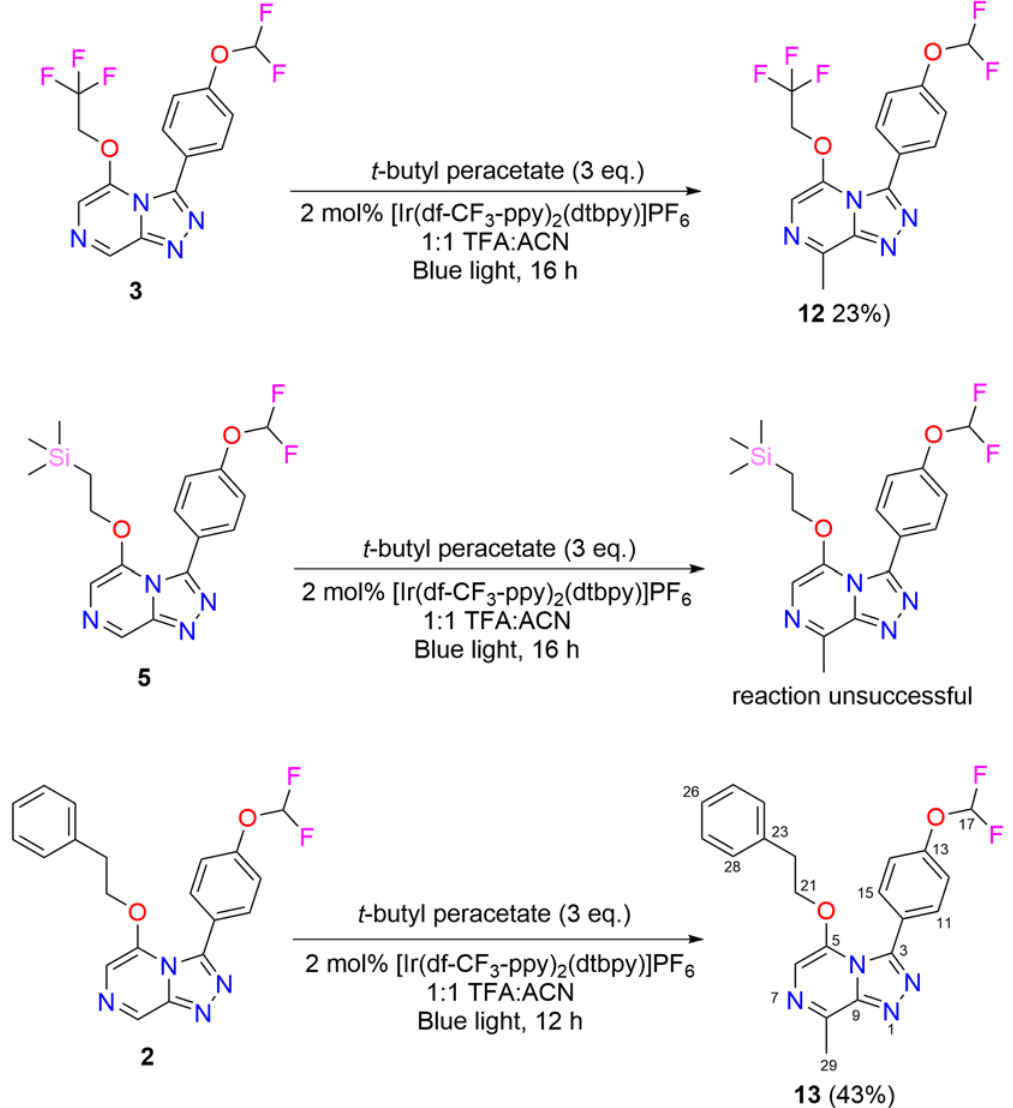
Scheme 5. Photoredox-catalyzed methylation of the scaffolds 2 , 3, and 5 . The structures of all synthesized methylated products were determined using 1D/2D NMR and HRMS (see Supplementary Materials). An example of full characterization for 13 is given below. Compound 13 was purified as a clear film and was assigned the [M + H] + . The 1 H NMR spectrum of 13 in DMSO- d 6 (Table 2) indicated the presence of two methylenes [ δ H 2.86 (H-22) and 4.42 (H-21)], 10 aromatic protons [ δ H 7.39 (H-6), δ δ H 7.74 (H-11 and H-15), 7.29 (H-12 and H-14), H 6.90 (H-24 and H-28), 7.17 (H-25 and H-27), 7.16 (H-26)], and a methyl singlet [ δ H 2.72 (H-29)]. The 1 J H-F splitting of a triplet (73.7 Hz) was used to identify the proton located in the difluoromethoxy group [ δ H 7.36 (H-17)]. Analysis of the COSY system allowed for two aromatic systems to be distinguished, with four aromatic protons [ δ H 7.74 (H-11 and H-15) and 7.29 (H-12 and H-14)] belonging to one system and five aromatic protons [ δ H 6.90 (H-24 and H-28), 7.17 (H-25 and H-27), and 7.16 (H-26)] belonging to the